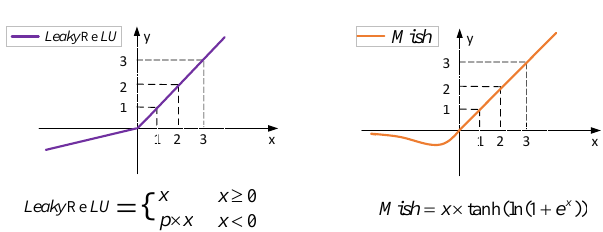
Figure 6 Mish and LeakyReLu formulas and images